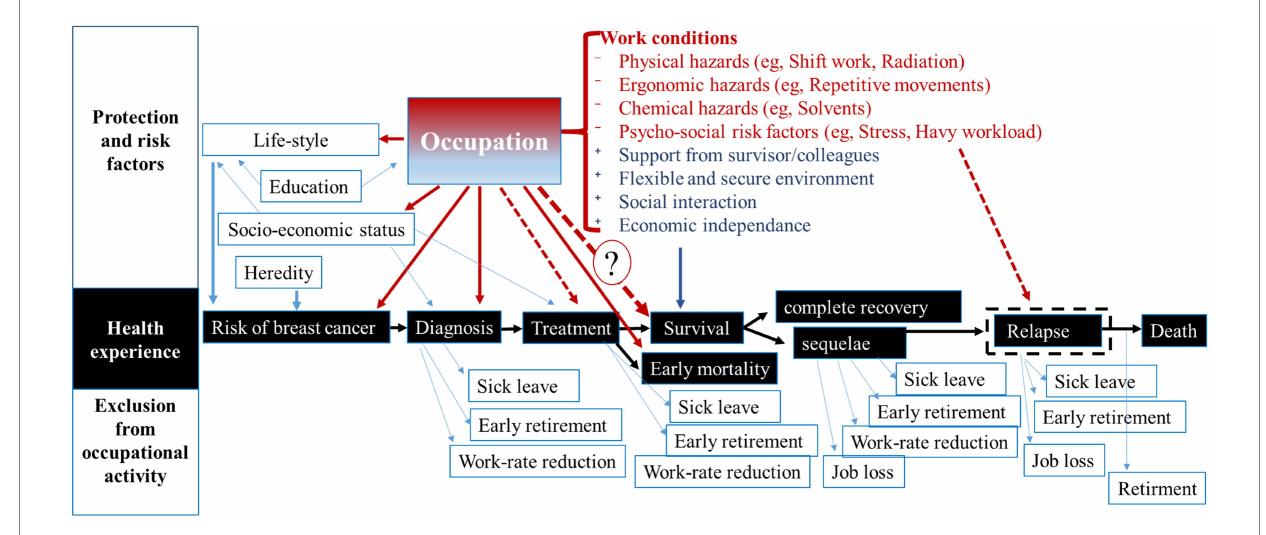
FIGURE 1 Relationships between occupation and breast cancer experience for a working woman. Dot-lines correspond to the hypothesized relationships, which have not been studied yet. Question mark indicates the relationship investigated in this study. Text in red corresponds to examples of breast cancer risk factors, text in blue corresponds to examples of protective